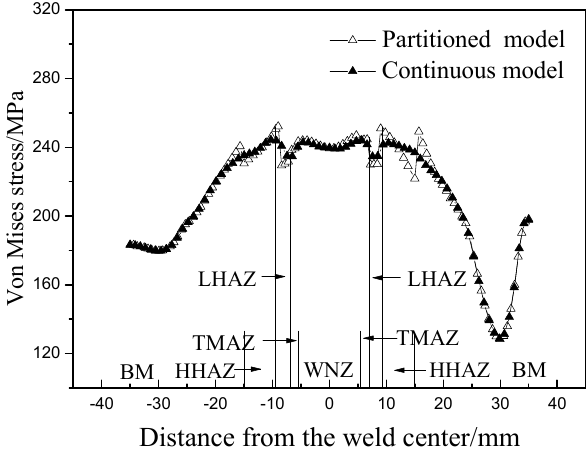
Figure 12. Von Mises stresses distributions of upper surface in the joint model.